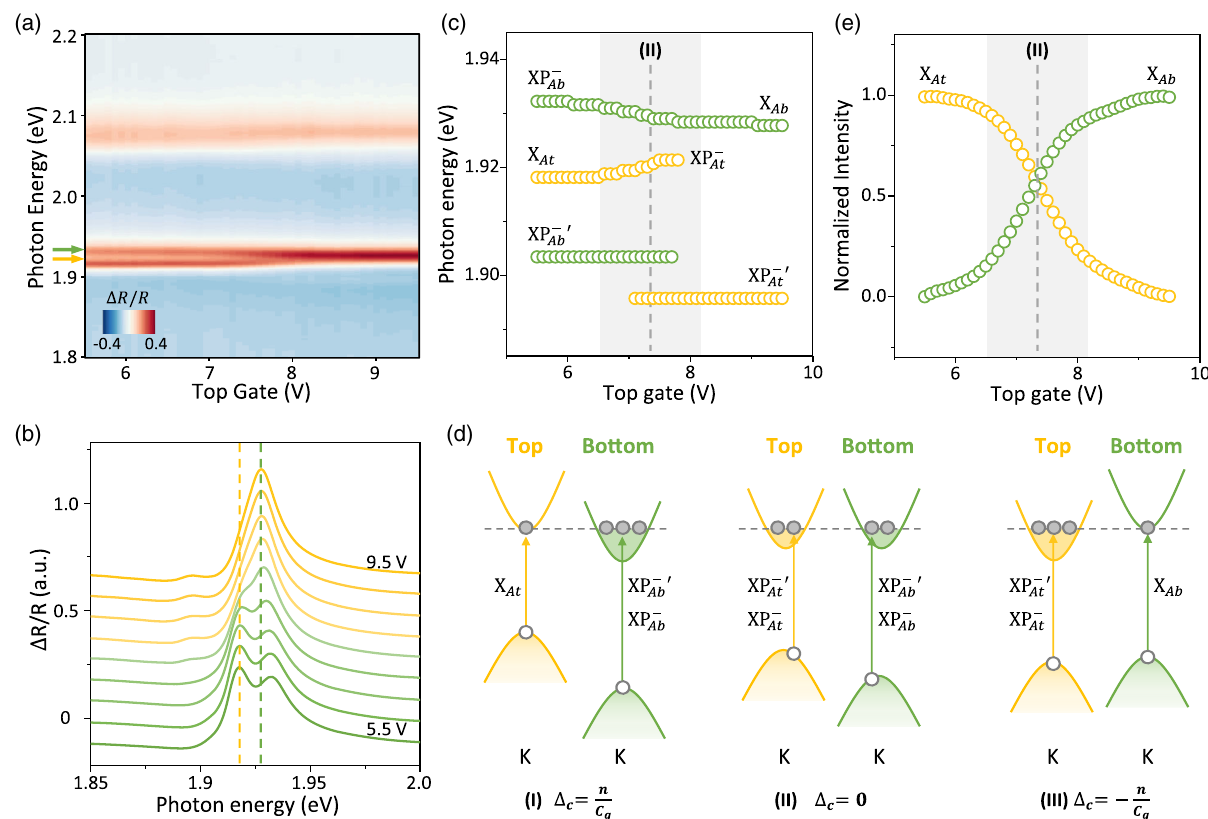
FIG. 3. Electric-field-dependent reflectance contrast spectrum of intralayer excitons in 3 R -MoS 2 bilayer at a fixed electron doping density. (a) Contour plot of the electric-field-dependent reflectance contrast spectrum of 3 R -MoS 2 bilayer at a fixed electron doping density. The yellow and green arrows denote the intralayer A exciton, X and X , from the top and bottom layers, respectively. At Ab ¼ − 0 . 85 V þ 1 . 65 . The (b) Reflectance contrast spectrum at different top gate voltages in steps of 0.5 V. The bottom gate voltage is V b t yellow and green dashed lines denote X and X from the top and bottom layers, respectively. (c) From low energy to high energy, At Ab electric-field dependence of XP − 0 (attractive exciton polaron in the top layer), XP − 0 (attractive exciton polaron in the bottom layer), X At At Ab or XP − (intralayer exciton or repulsive exciton polaron, respectively, in the top layer), and X or XP − (intralayer exciton or repulsive Ab At Ab exciton polaron, respectively, in the bottom layer) energies extracted from (a). (d) Schematics of band alignment and existing optical transitions of a BA -stacked 3 R -MoS 2 bilayer at a fixed electron doping density when (I) the Fermi level reaches the conduction band ¼ n=C edge of the top layer with Δ , (II) the Fermi level is in the conduction band of both layers and electrons are equally doped into c q ¼ 0 , and (III) the Fermi level is at the conduction band edge of the bottom layer with Δ ¼ − n=C . (e) Normalized two layers with Δ c c q intensity changes of X and X extracted from (a) along the fixed photon energy indicated by yellow and green arrows. The crossing At Ab point denotes the same oscillator strength of XP − and XP − when the conduction band offset is zero as shown in the middle panel of At Ab